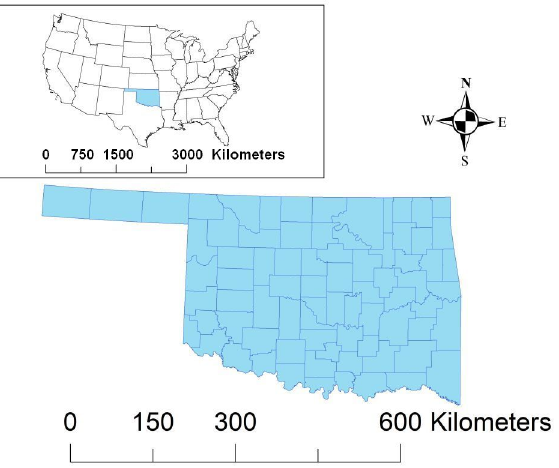
Figure 1. The state of Oklahoma (shown in blue) is located in southern Great Plains of the United States of America, and contains 77 counties. States of America, and contains 77